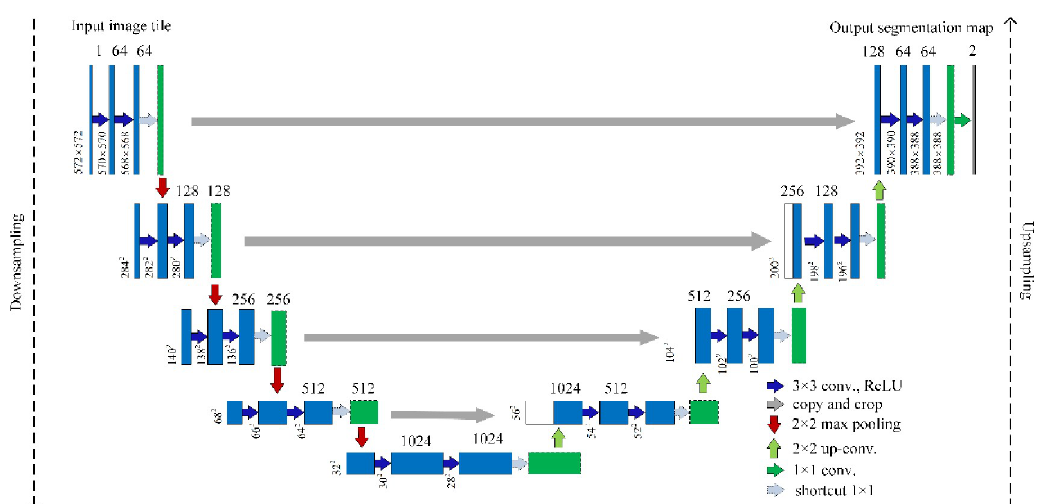
Fig 5. The architecture of the U-Net based segmentation network with shortcut module.